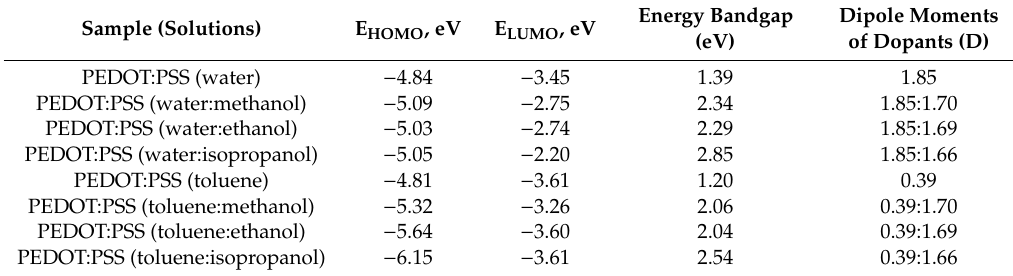
Table3. Summaryofselectedelectrochemicalvaluesanddipolemomentsforaqueousandtoluene-based solutions of PEDOT:PSS with and without of